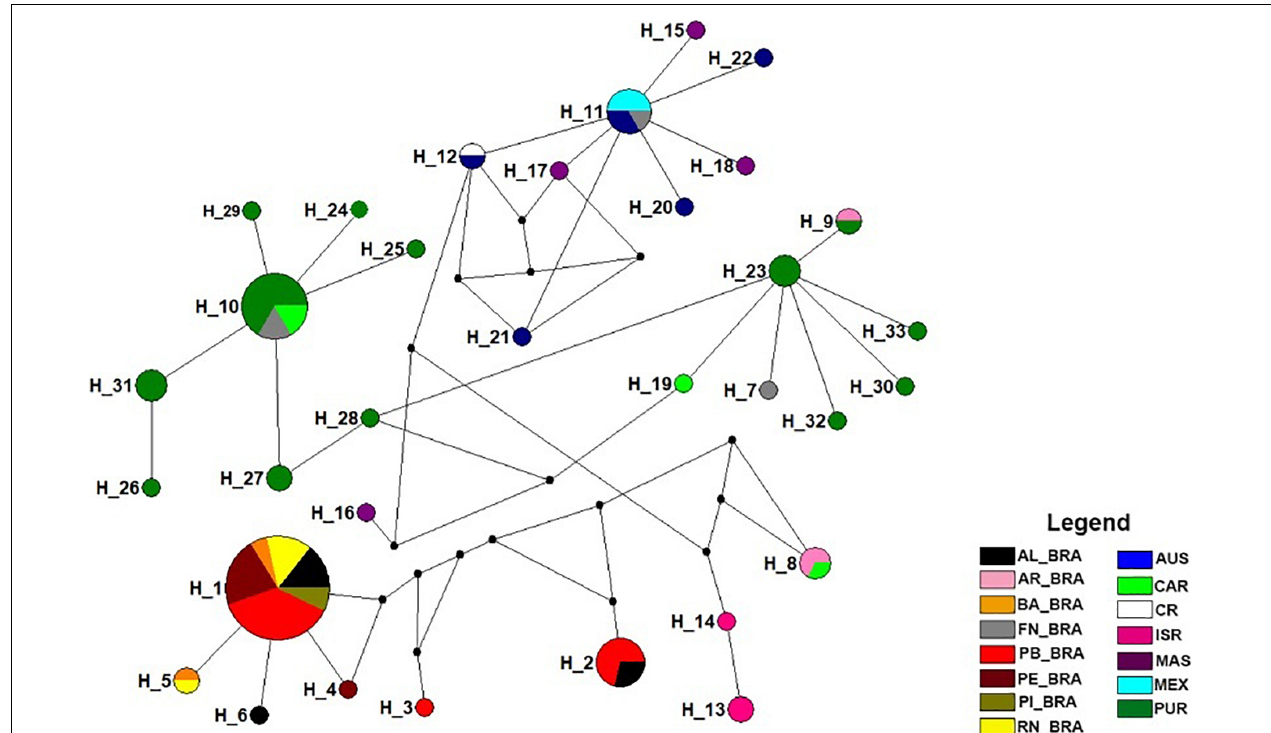
FIGURE 2 | Haplotype network showing the relationships between the 33 haplotypes recorded in the 15 populations of Eretmochelys imbricata . Each circle corresponds to a haplotype, the size being proportional to its frequency. The colors represent the occurrence of haplotypes in the evaluated populations and the small black circles represent the mutational steps. Nesting áreas: Piauí—PI_BRA; Alagoas—AL_BRA; Bahia—BA_BRA; Rio Grande do Norte—RN_BRA; Pernambuco—PE_BRA; Paraíba—PB_BRA. Feeding áreas: Atol das Rocas—AR_BRA; Fernando de Noronha—FN_BRA; Costa Rica—CR; Mexico—MEX; Malaysia—MAS; Caribbean—CAR; Australia—AUS; Puerto Rico—PUR; Israel—ISR.